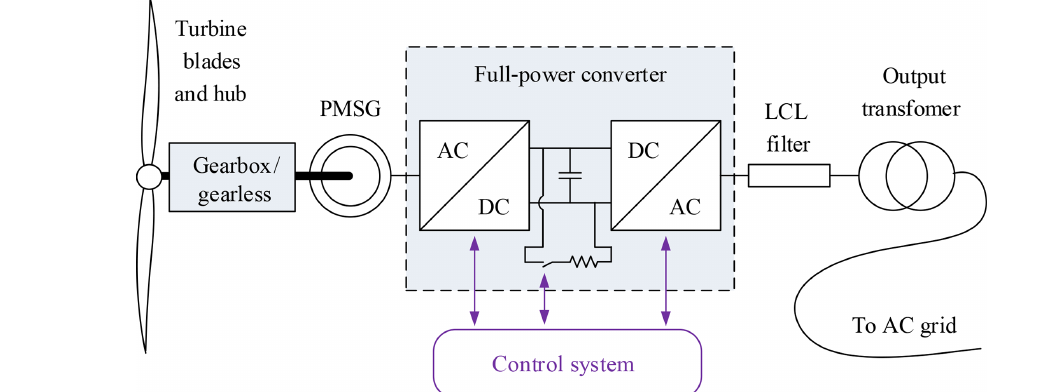
Figure 4. Schematic representation of an FPC wind turbine.